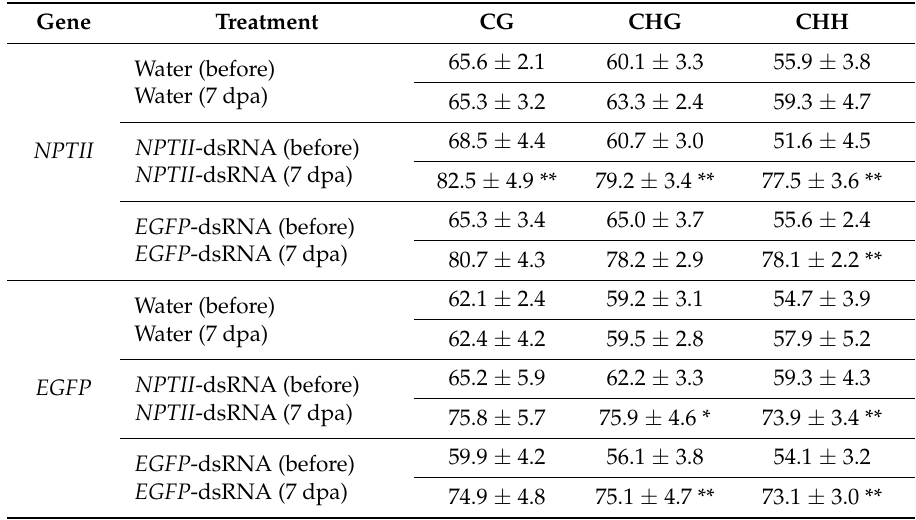
Table 1. Methylation status in the NPTII and EGFP transgene protein-coding regions in the transgenic L1 line of A. thaliana before and 7 days after foliar application of NPTII -dsRNA, EGFP -dsRNAs, or filtered sterile